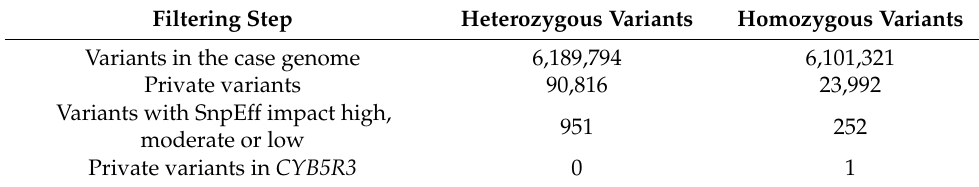
Table 3. Variant filtering results of the affected cat against 74 control